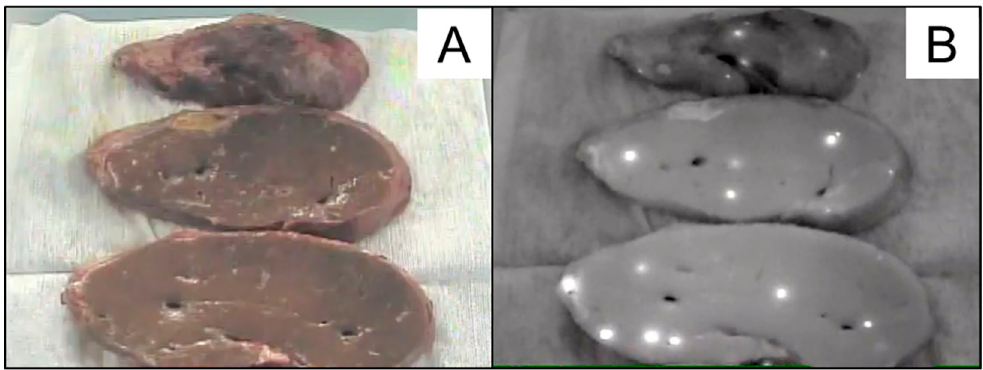
Figure 4. ( A ) The sliced explanted liver in white-light mode and ( B ) near-infrared mode. The hot spots in near-infrared mode were compatible with hepatoblastomas in histology, macroscopic image